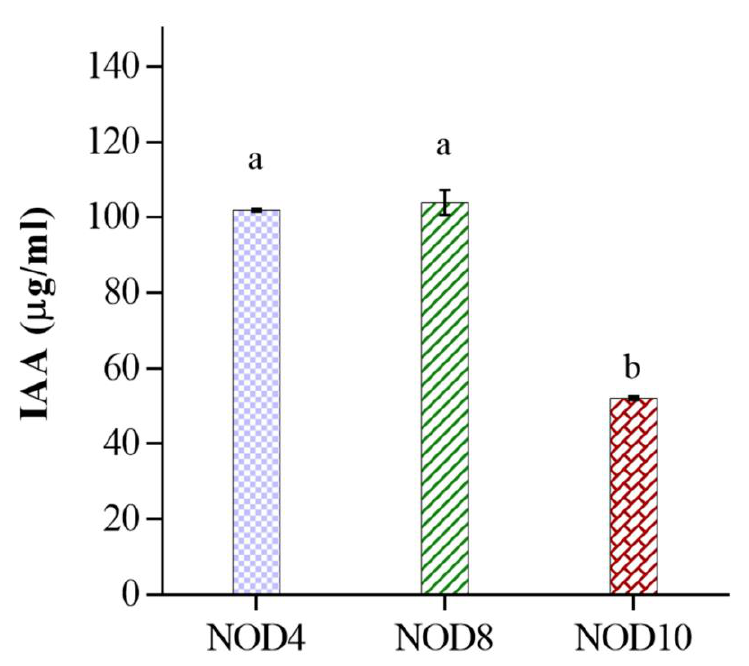
Figure 3. IAA quantification of the three Enterobacter strains. Media was supplemented with trypto- phan. Different symbols at the top of the bars indicate a statistically significant difference ( p < 0.05). The Enterobacter sp. NOD4, E. mori NOD8 and E. asburiae NOD10 were inoculated in